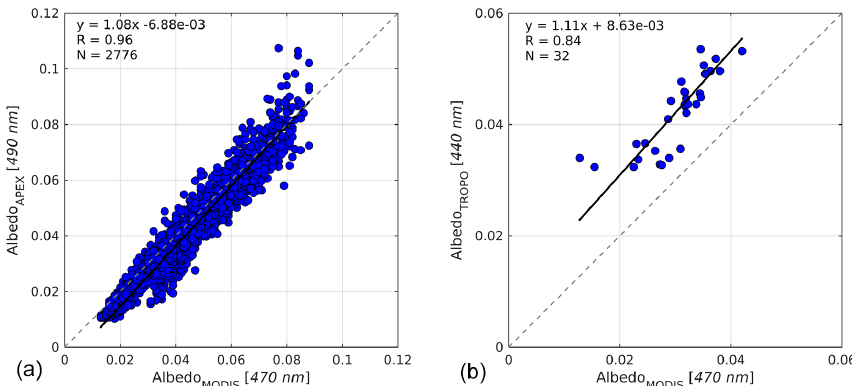
Figure 5. Scatter plots and linear regression analyses of co-located (a) APEX and MODIS, and (b) TROPOMI and MODIS albedo pixels for 27 June